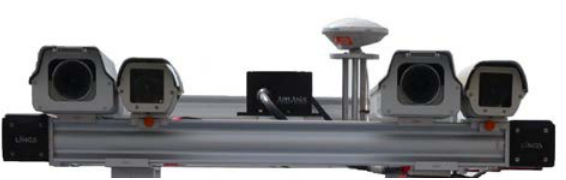
Figure 3. Camera configuration used for the test